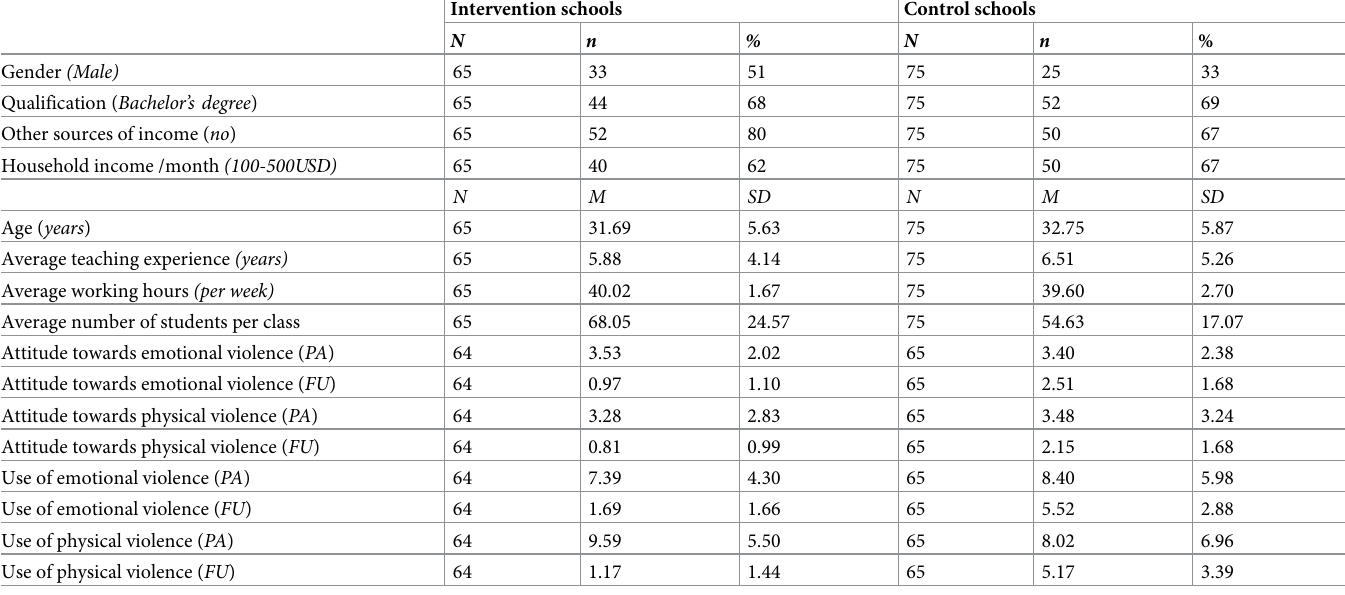
Table 1. Descriptive statistics of the teacher sample in intervention and control schools at pre- and follow-up assessment.